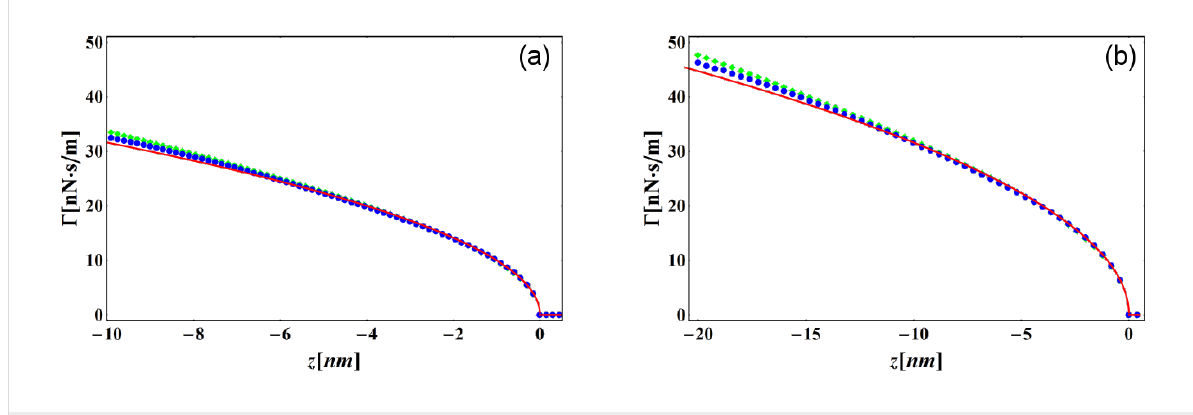
force curve from any single harmonic, obviating existing recon- struction methods based on simultaneous measurement of multiple higher harmonics. In addition, it was shown that in the small amplitude regime, short range forces are reconstructed more accurately by higher harmonic analysis compared with the fundamental harmonic